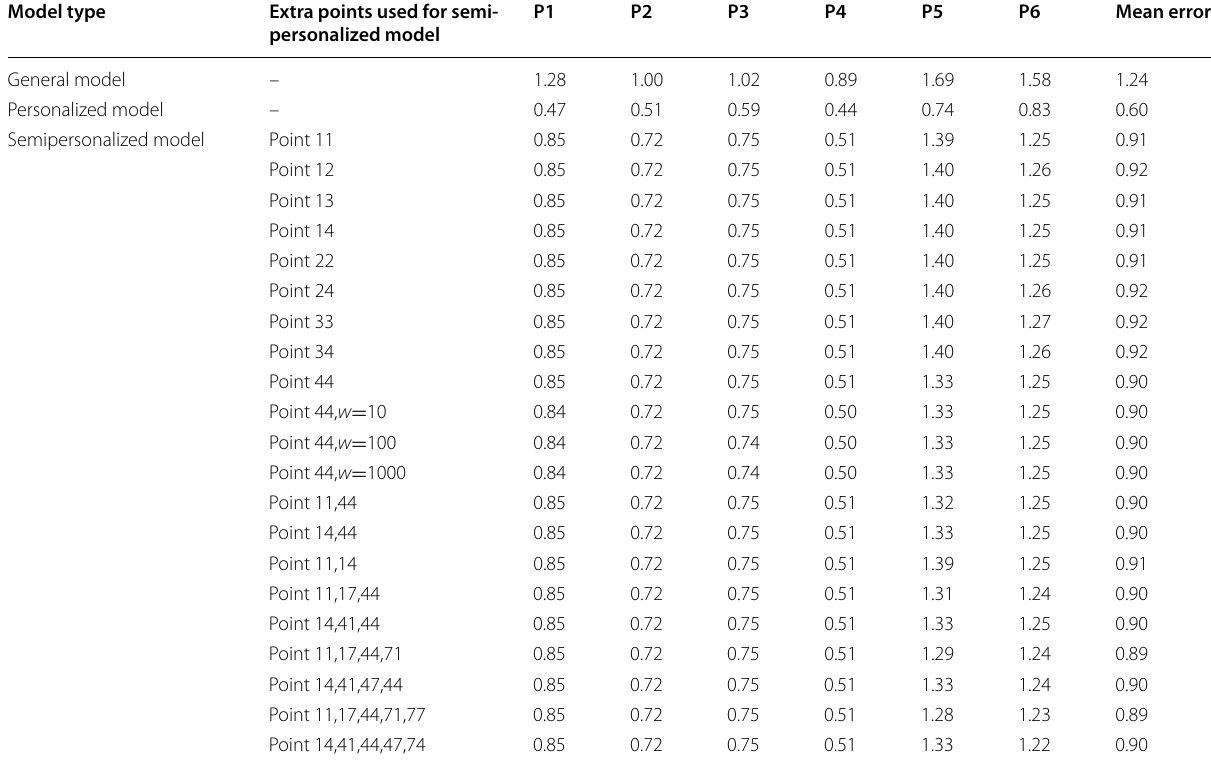
Table 1 Mean localization errors (cm) of the personalized, general, and semipersonalized models for participants P1 to P6. For the semipersonalized model, weight w = 1 unless otherwise specified Model